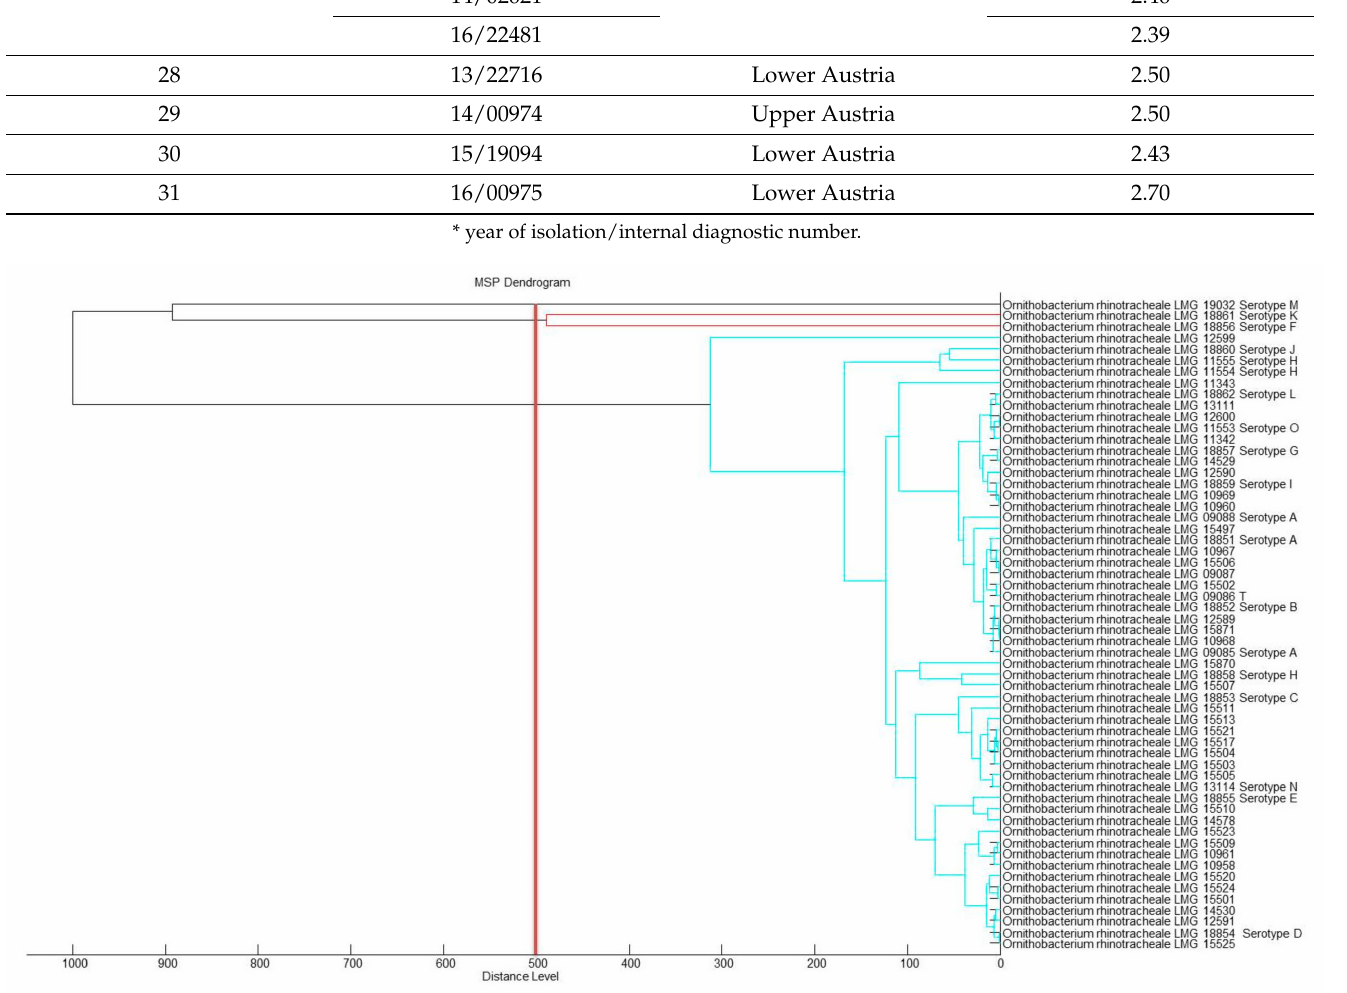
Figure 1. MSP dendrogram of 59 reference strains based on MALDI-TOF MS. Serotypes A, B, C, D, E, G, H, I, J, L, N are concentrated in one cluster. Serotypes F, M and K group into a separate